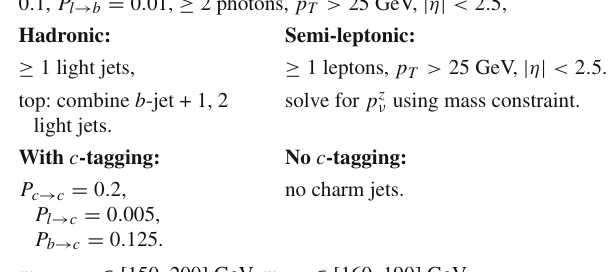
Table 3 A summary of the selection criteria of the analysis for each of the channels considered for the pp → t ¯ t → ( hc ) ¯ t process. The final invariant mass cut, on m γγ c allows identification of the signal top quark Exactly one b -jet, p T > 25 GeV, | η | < 2 . 5, P b → b = 0 . 7, P c → b =